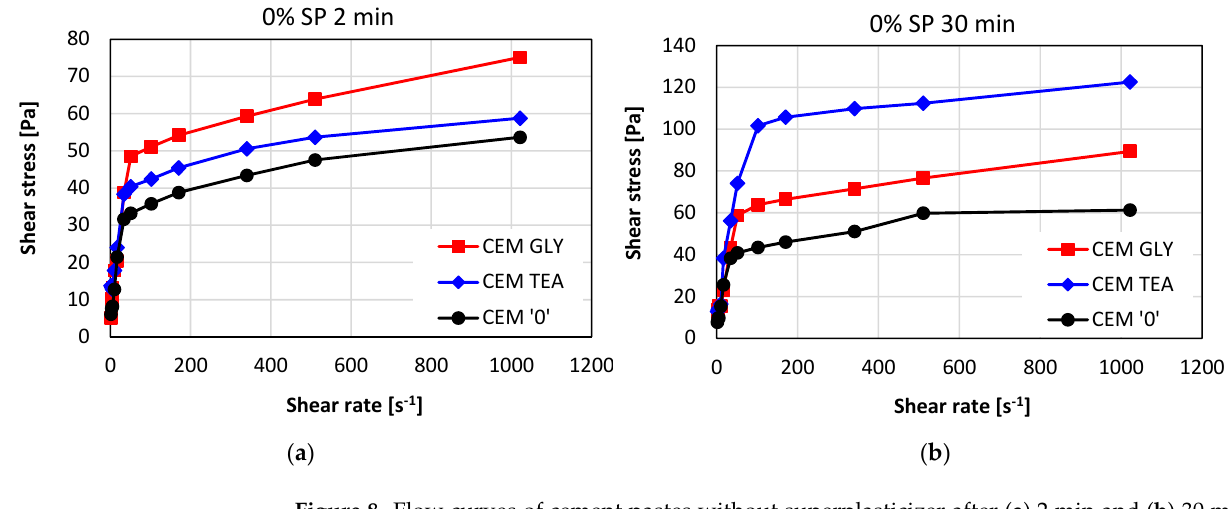
Figure 8. Flow curves of cement pastes without superplasticizer after ( a ) 2 minutes and ( b ) 30 minutes of hydration; w/c ratio = 0.6.